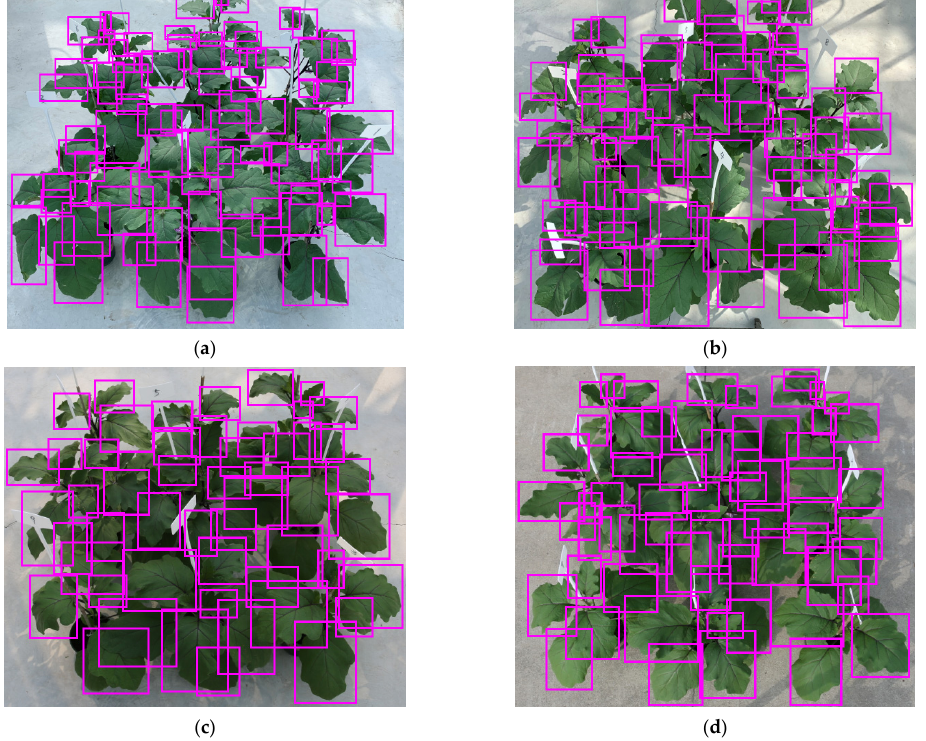
Figure 12. Detection results of eggplant leaf under different indoor and outdoor light conditions: ( a ) weak indoor light; ( b ) sufficient indoor light; ( c ) weak outdoor light; ( d ) sufficient outdoor light. In Figure 11, the detection at moderate light condition shows higher accuracy than that at 12:00 with high-intensity direct light. Table 2 shows that leaf detections at 10:00 and 14:00 also provide relatively high accuracy with low false alarm and missed detec- tion. Comparing the data of correct detection ratio, false alarm ratio and missed detec- tion ratio in table2, the improved CenterNet shows better performance than the original CenterNet. Table 2. Comparison of leaf detection accuracy for images acquired at different outdoor time periods. 50 images were collected for each time period, each image contains 60 leaves. Acquisition Time